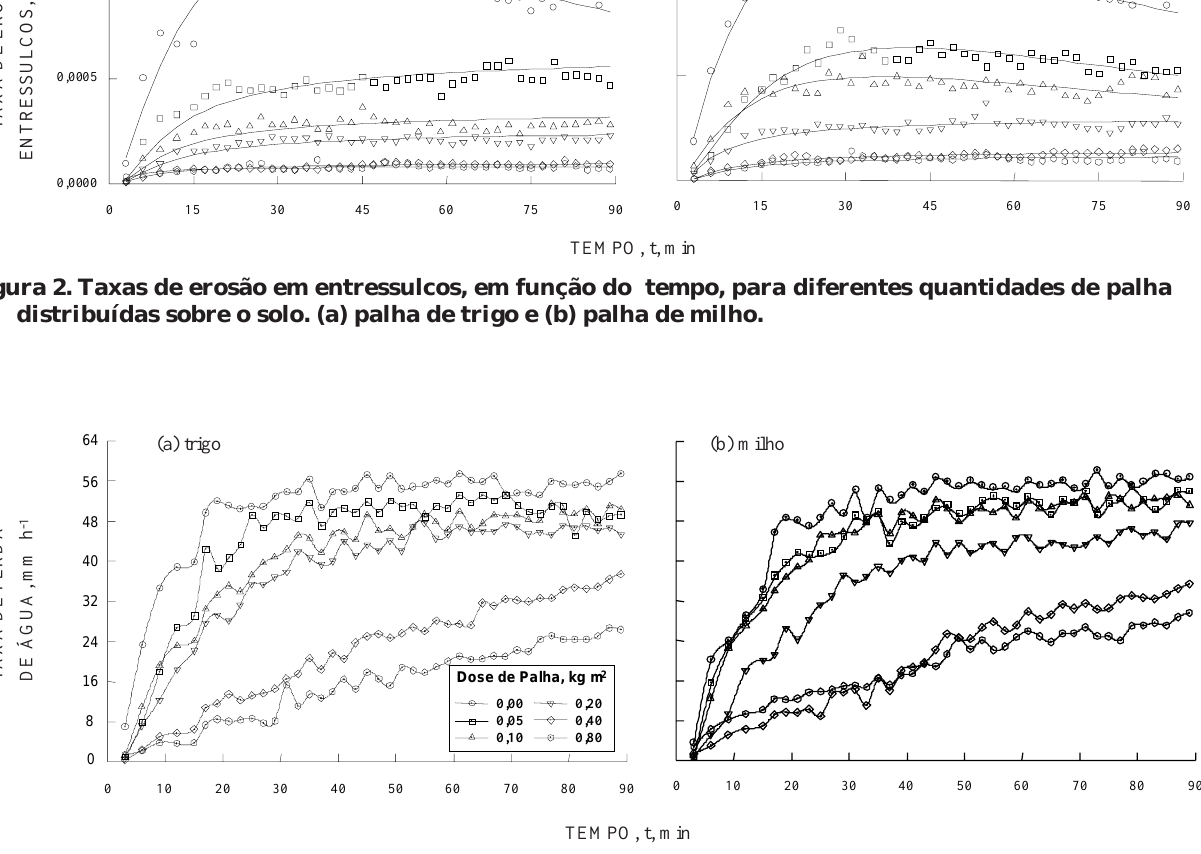
Figura 3. Taxas de perdas de água nos entressulcos, em função do tempo, para diferentes quantidades de palha distribuídas sobre o solo. (a) palha de trigo e (b) palha de